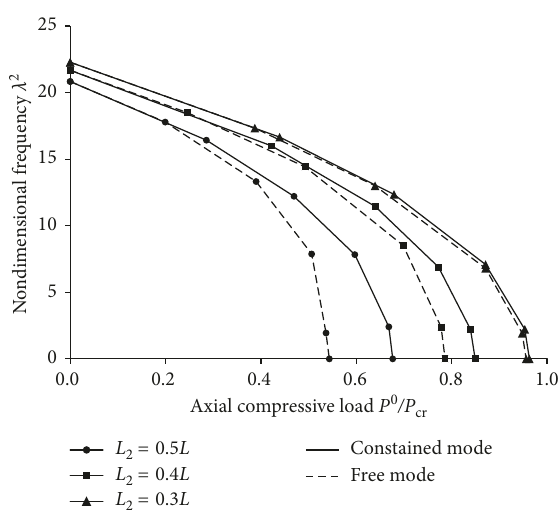
Figure 7: Trend of change in fundamental natural frequencies ( λ 2 ) with respect to normalized buckling load P 0 / P cr for both con- strained and free modes with H 2 / H ferent values of L 2 / L .